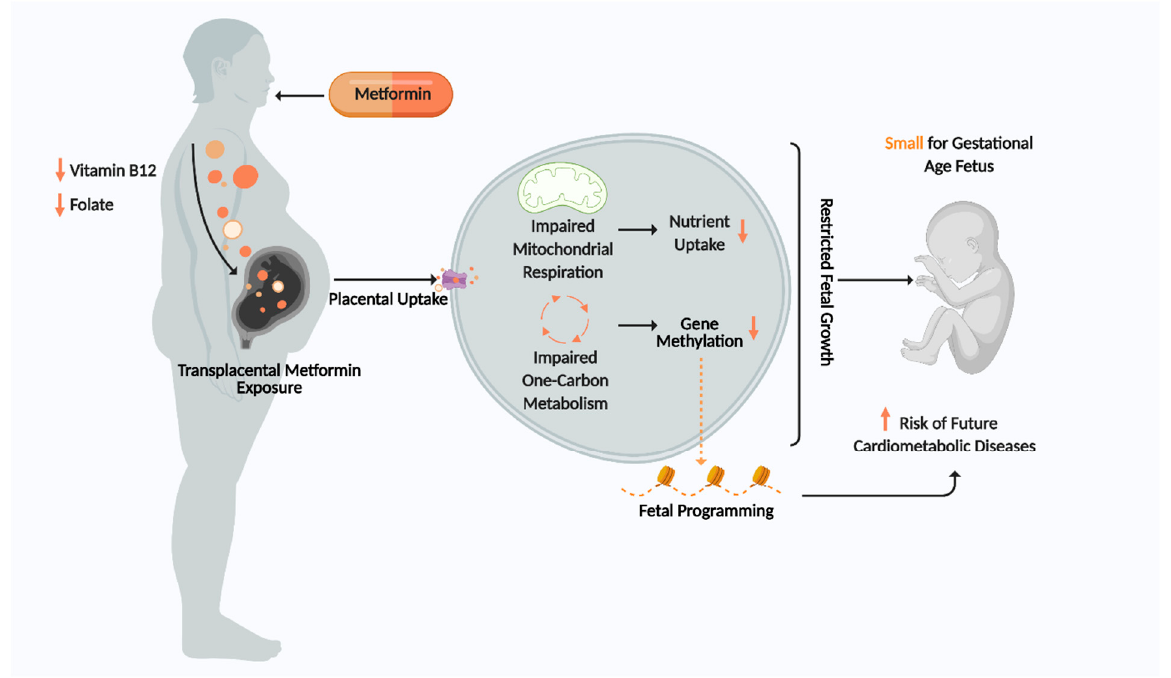
Figure 4. Summary of Proposed Mechanism for metformin effects on placenta and fetus. Figure created using Bioren- der.com.